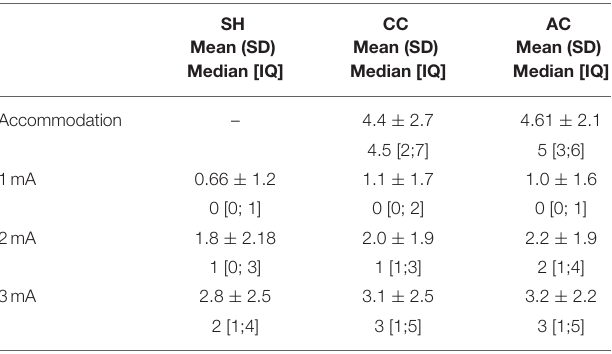
TABLE 1 | Descriptive data of visual analog scale score for discomfort, with each HD-tDCS 3 × 1 condition and current